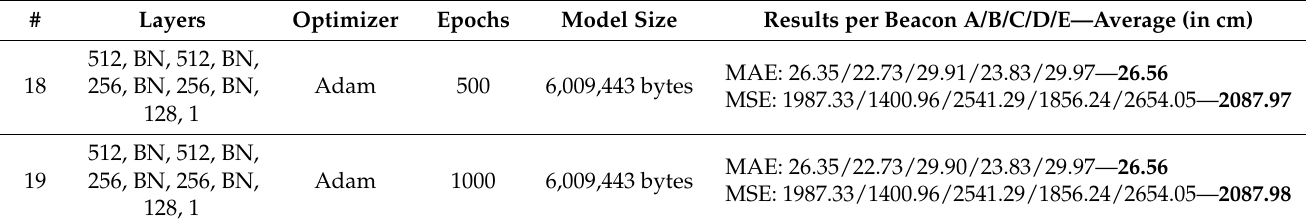
Table 8. Experiments No. 18 and No. 19 parameters and